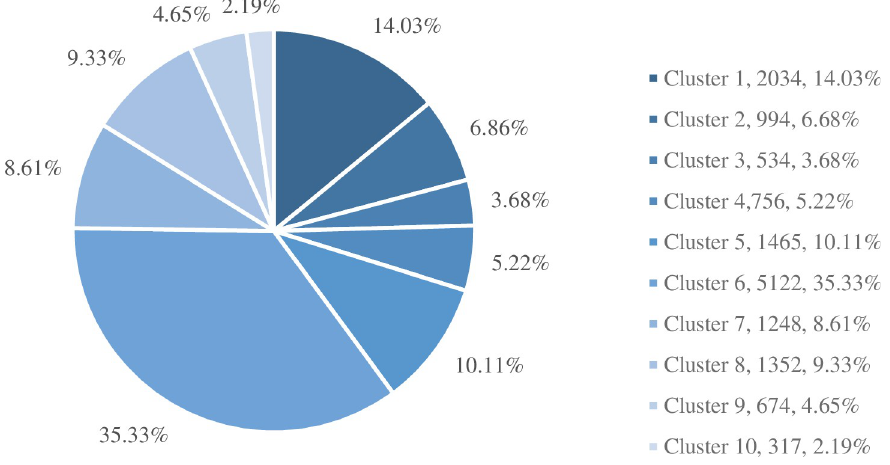
Fig 3. The proportion of vacancies in all